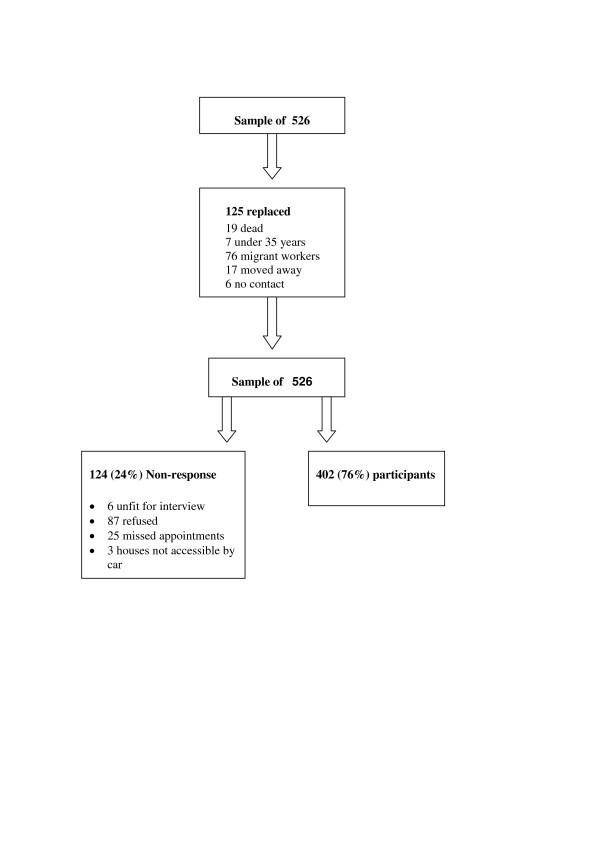
Replacements and final response rate.